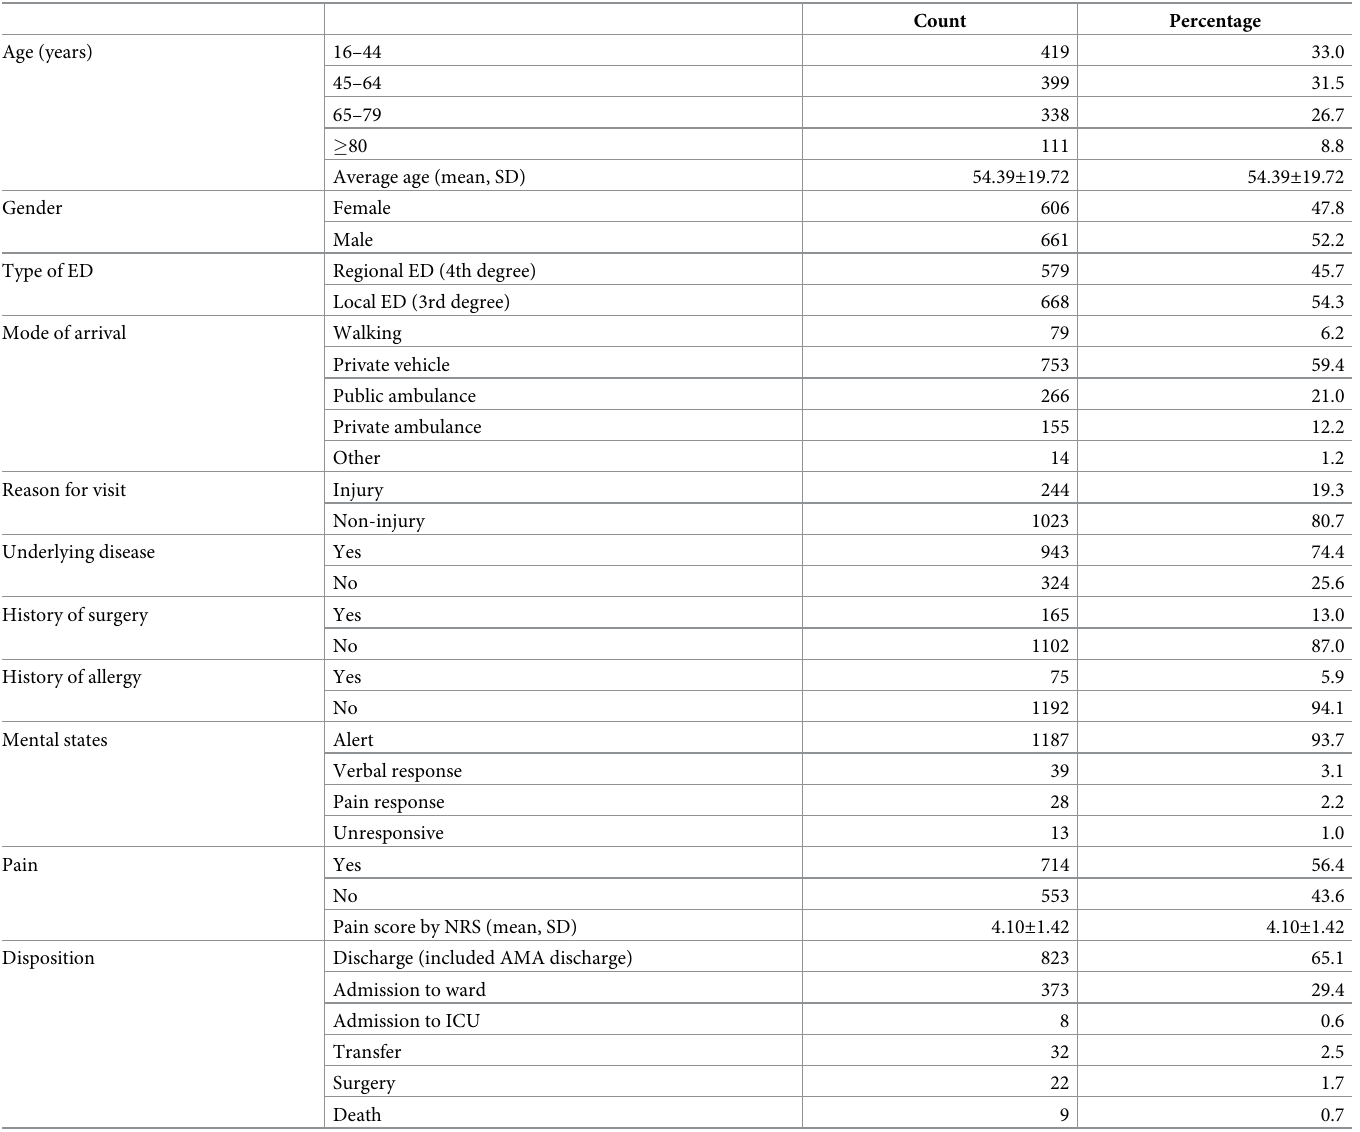
Table 1. Demographic data of